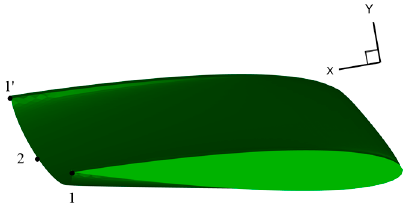
Figure 5. Shape description of the flexible NACA foil.